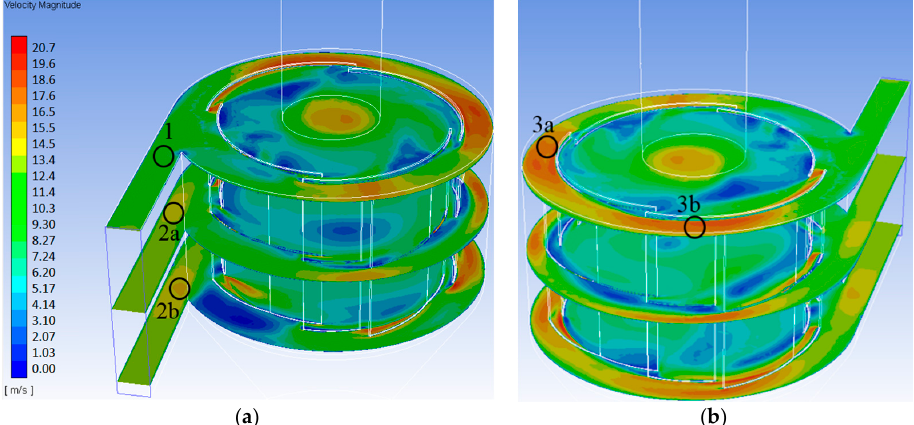
Figure 5. The distribution of gas flow rates in the separation chamber of the multi ‐ channel cyclone separator at the heights of 5 cm (point 2b), 15 cm (point 2a), and 25 cm (point 1), front ( a ) and back ( b ) views for obtaining an overall 360° angle view, the end sections of the first (point 3b) and the second (3a) channels